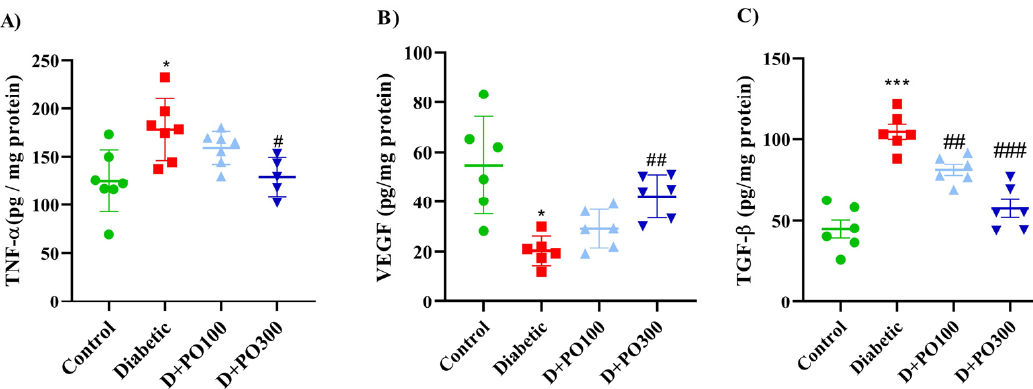
Tukey–Kramer’s post hoc test; * p < 0.05, *** p < 0.001 vs. control group; ### p < 0.001 vs. diabetic group.